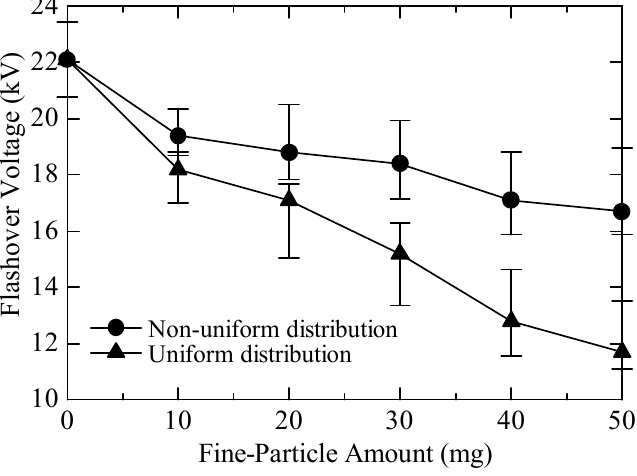
Figure 8. Relationship between the flashover voltage and the fine ‐ particle amount with a particle size of 24 μ m.